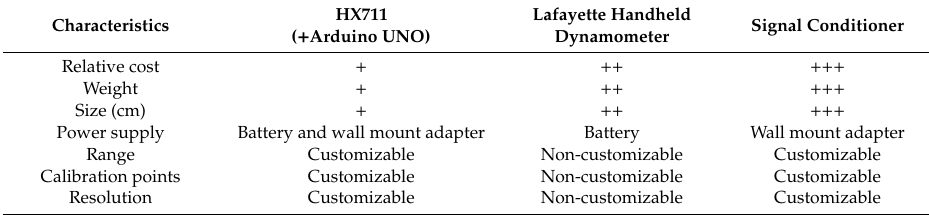
Table 1. A relative comparison between the three different instruments (Lafayette handheld dynamometer, the commercial signal conditioner and the HX711 microcontroller-based load cell amplifier) used for measuring